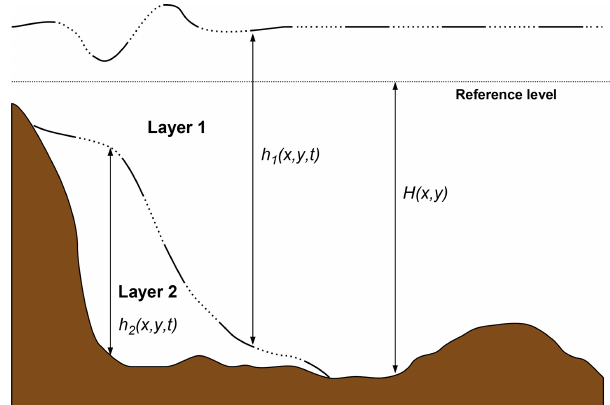
Figure 5. Sketch of the two-layer model. Relation among h 1 , h 2 , and H